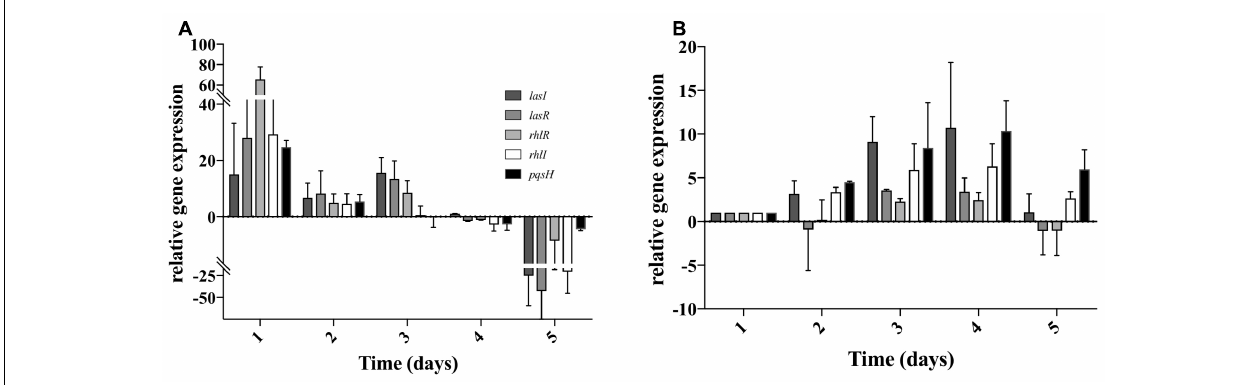
FIGURE 4 | Pseudomonas aeruginosa QS gene expression when co-cultured with S. aureus on tube reactors. S. aureus biofilms were cultured in tube reactors for a period of 5 days previous to the introduction of P. aeruginosa . Once P. aeruginosa aeruginosa was introduced (day 0), samples were taken at 24 h intervals for a period of 120 h. (A) relative expression of P. aeruginosa compared to single species biofilms, (B) relative expression of P. aeruginosa QS genes in dual-species biofilms compared to day 1 of co-culture. Changes of relative expression were considered significant when a twofold change was present.